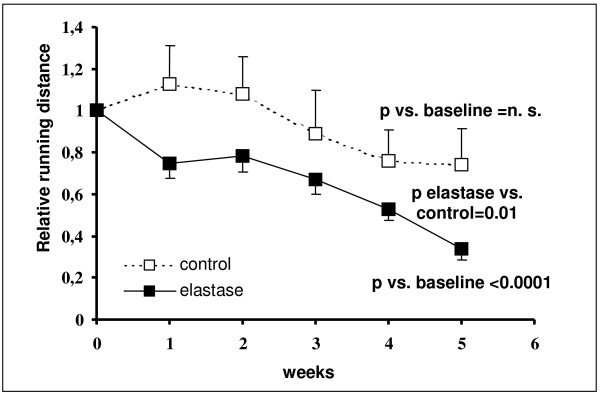
Exercise tolerance of elastase treated (protocol 2) and control mice. Shown are the running distances at the follow-up evaluations after the respective elastase treatment normalized to the baseline running distance (week 0). The relative running distance after the last elastase instillation was significantly shorter in the elastase group than in the control group.